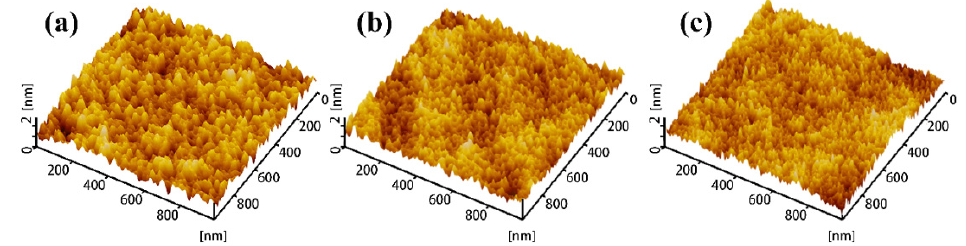
Figure 3. AFM image of ( a ) Y 2 O 3 , ( b ) Y 2 O 3 –Al 2 O 3 (ALD) and ( c ) Y 2 O 3 –Al 2 O 3 (solution processed).